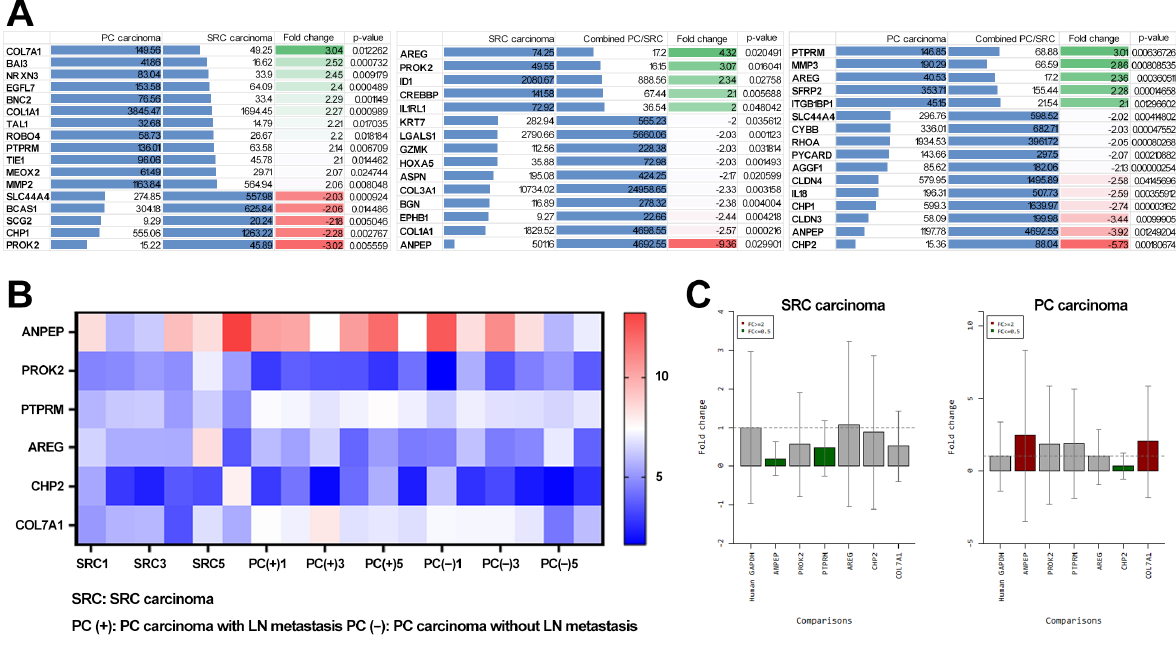
Figure 3. ( A ) Gene expression patterns of signet ring cell (SRC) carcinoma, poorly cohesive (PC) carcinoma, and combined PC and SRC carcinoma using Nanostring assay. ( B , C ) ANPEP, PROK2, PTPRM, AREG, CHP2, and COL7A1 gene expression in SRC and PC carcinomas was compared us- ing ( B ) Nanostring and ( C ) RT-PCR assay.